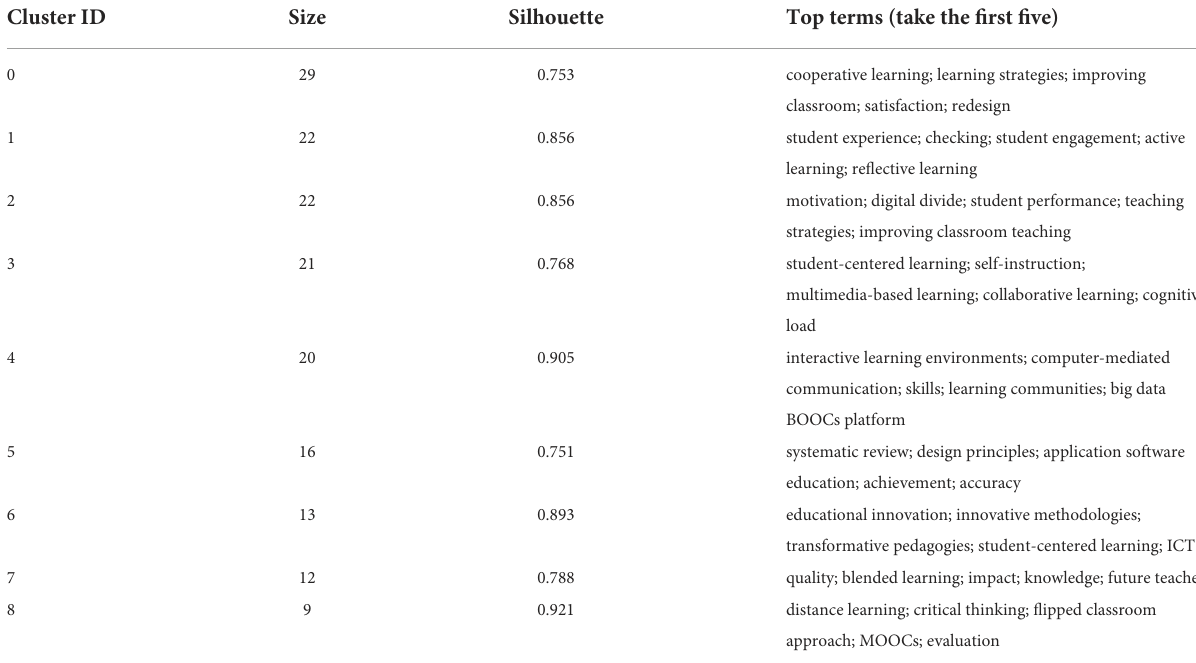
TABLE 3 High-frequency keywords clustering